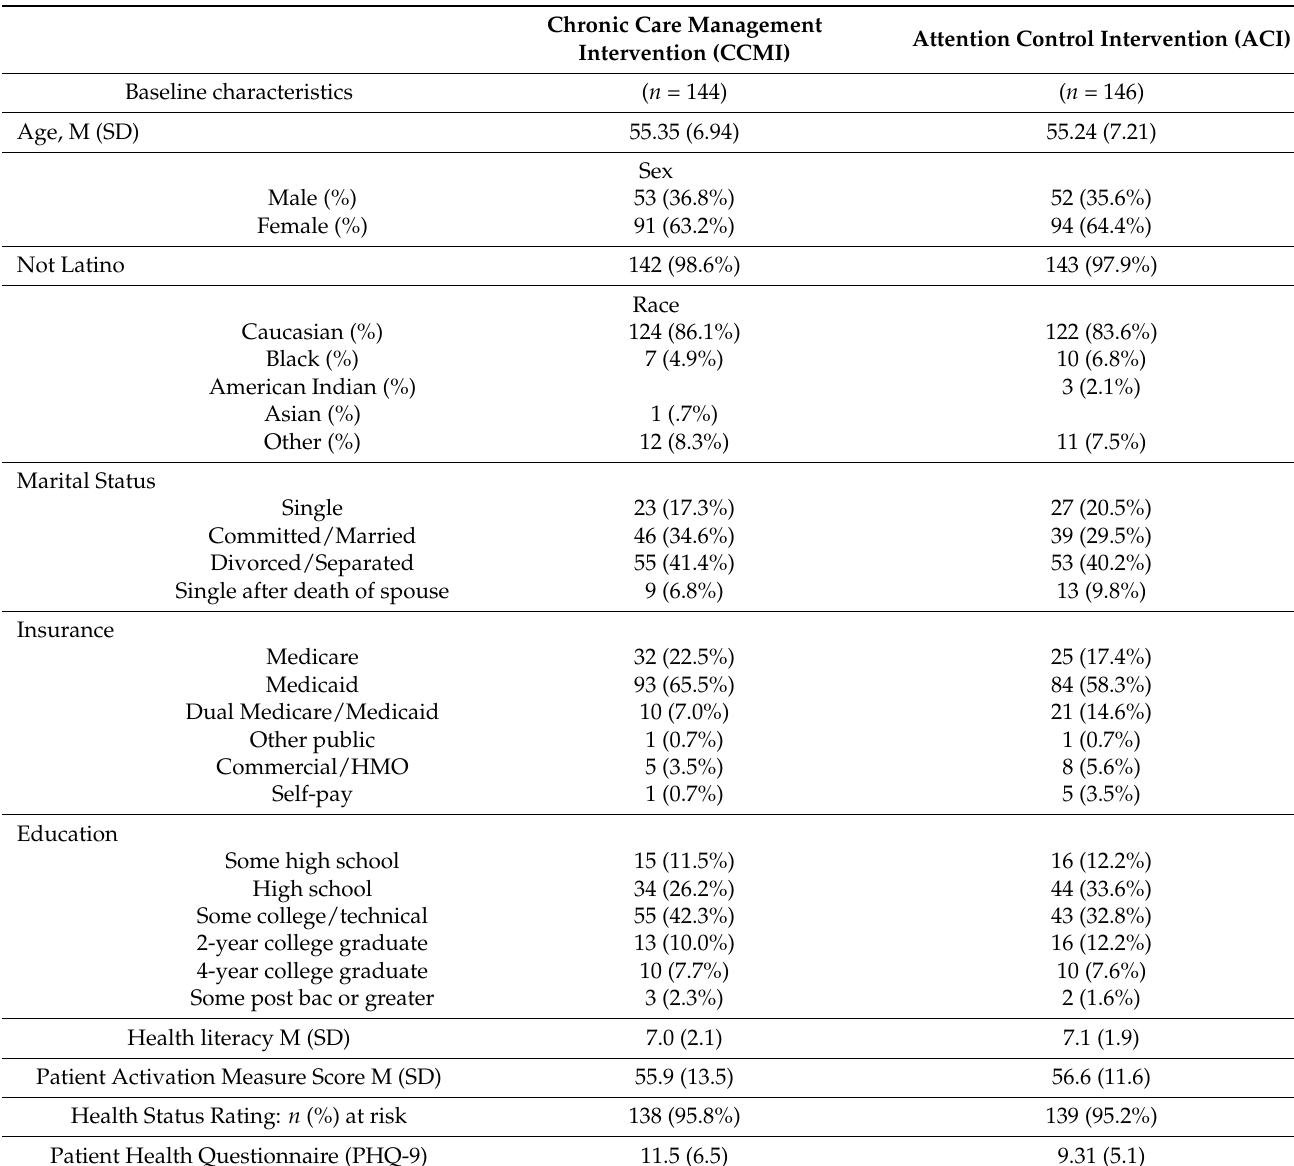
Table 1. Participants’ baseline